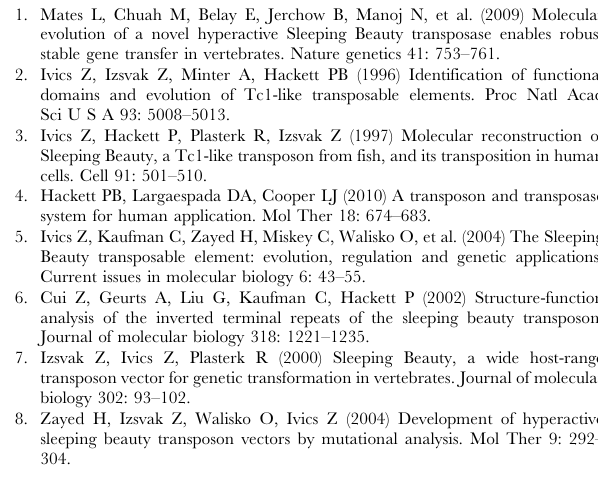
Figure S1 Transposition trend. Expression of Venus fluorescence protein was detected by cytofluorimetric analyses at different time points in HeLa cells (A) and in GABEB cells (B). The days post transfection (p.t.) are plotted on the X axis, while the percentage of Venus + cells are represented on the Y axis. The maximum expression from a transfected reporter gene was achieved 2 days p.t (black vertical dotted line). The plot shows the samples co-transfected with SB100X and transposon plasmids: T2 3.2 or the SA 5.7 (blue), T2 10 or SA 9.7 (green), T2 14 or SA 14 (purple), and the 18 kb transposons (orange). SA constructs represented with dashed lines, T2 with continuous lines. In gold are represented the negative controls transfected with T2 3.2 or SA 5.7 alone, without the SB100X plasmid. Table S1 List of primers used for plasmid episomial amplification, LM-PCR, and site-specific amplification of the SA-genome junctions. Table S2 Transposed clones were analysed to show the following parameters: number of retrieved Venus + clones for each bulk; percentage of Venus + cells in bulk populations 48 hours p.t.; percentage of stable Venus expressing cells in bulk populations; percentage of clones positive for the Ampicillin or SB100X sequence carried by transfected plasmids; mean copy number retrieved by Southern blot analysis; recombinant events detected in transposed clones by Southern blot